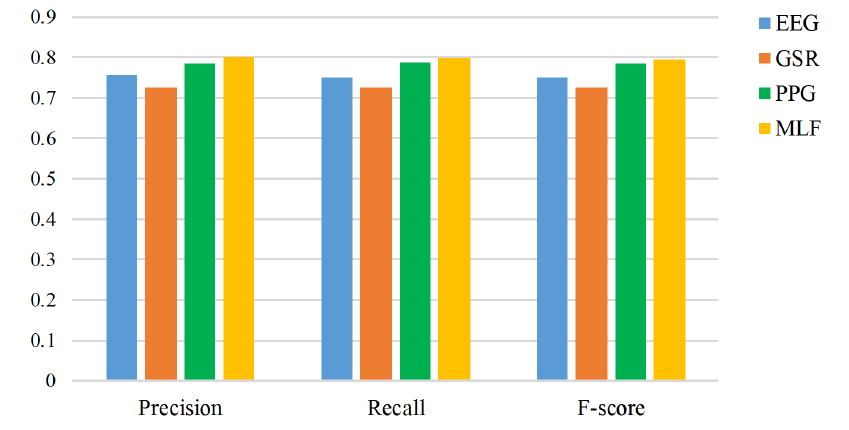
Figure 6. Precision, recall, and F-score in response to TEM using EEG, GSR, PPG, and